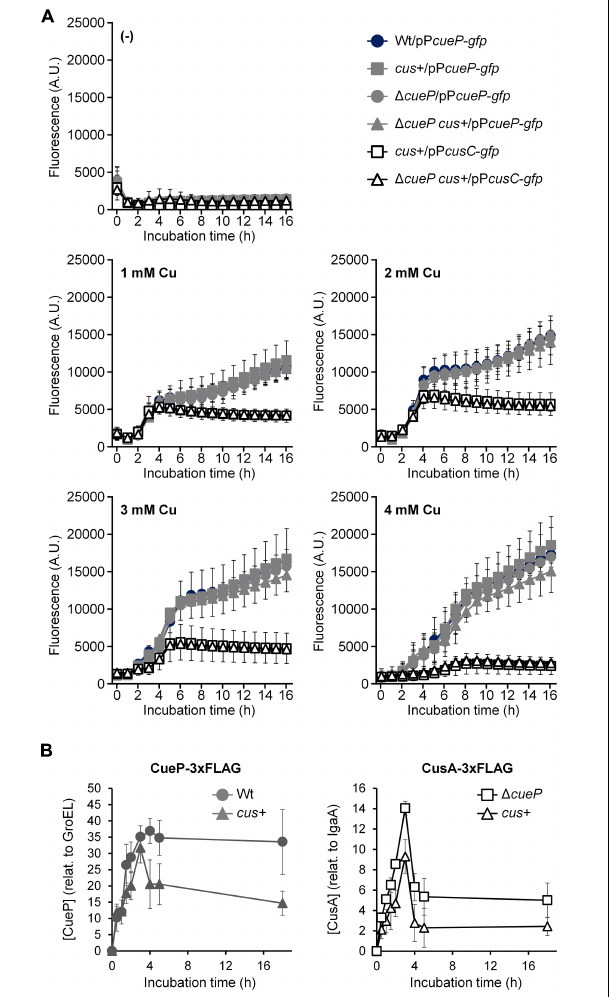
FIGURE 3 | Comparative analysis of the Cu-induced expression of the cus locus and cueP . (A) Kinetic analysis of the Cu-induced fluorescence from the wild type, the cus +, the (cid:49) cueP , or the (cid:49) cueP cus +, harboring gfp transcriptional fusions to either P cueP or the P cusC promoter, as indicated. Either 0, 1, 2, 3, or 4 mM CuSO 4 was added to cells exponentially grown in Luria–Bertani broth (LB), and both fluorescence and OD 600 nm (see Supplementary Figure 3 ) were recorded for 16 h and used to calculate the normalized fluorescence expressed as arbitrary units. The data correspond to mean values of at least three independent experiments performed in duplicate. Error bars represent SD. (B) Kinetic analysis of the Cu-induced CueP-3xFLAG or CusA-3xFLAG expression from the cueP- 3xFLAG (Wt), the cus + cueP- 3xFLAG cusA- 3xFLAG ( cus +), or the cus + cusA- 3xFLAG (cid:49) cueP ( (cid:49) cueP ) strains. Soluble or insoluble extracts from cells grown in LB with the addition of 2 mM CuSO 4 were analyzed by SDS/PAGE, followed by transfer to nitrocellulose, and developed using monoclonal anti-FLAG antibodies as described in the Materials and Methods Section. CueP or CusA relative levels were normalized to GroEL or IgaA, respectively. The data correspond to mean values of three independent experiments. Error bars represent SD. A representative western blot is shown in Supplementary Figure 4